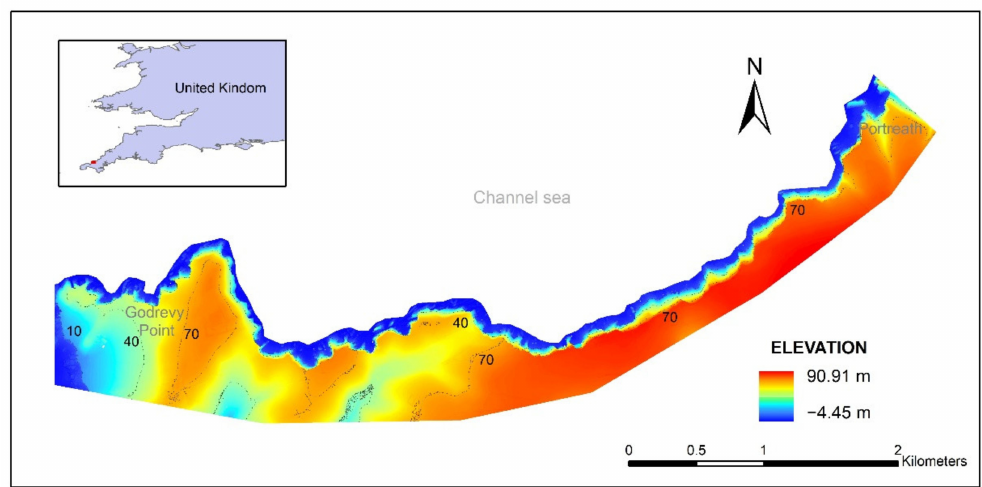
Figure 1. The study area, which is a section of costal rock cliff located on the north coast of Cornwall,